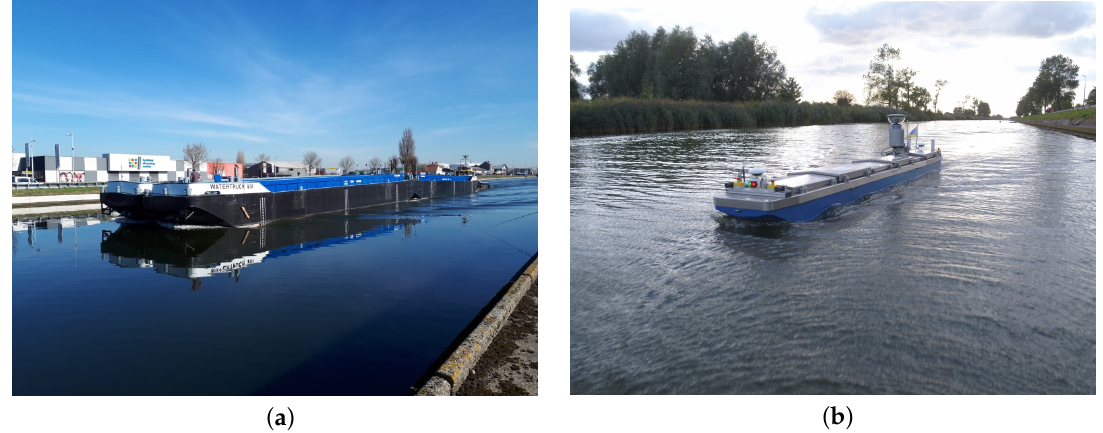
Figure 1. ( a ) Four real-size barges, with individual lengths of 38.50 m, and a push vessel from Watertruck + [6], and ( b ) the KU Leuven scale model with a length of 4.81 m from [7,8] with additional sensors for environment